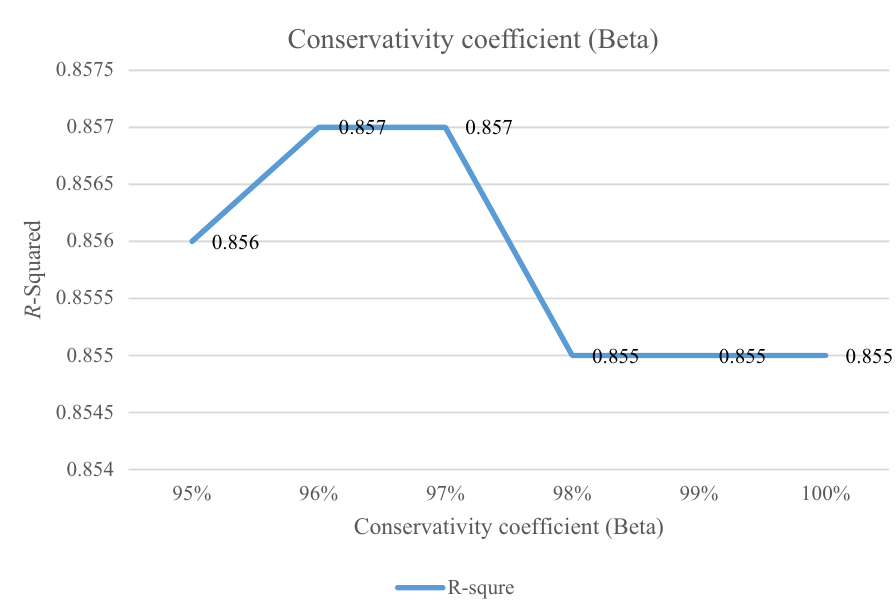
Figure 9. R-squared for conservativity coefficient.